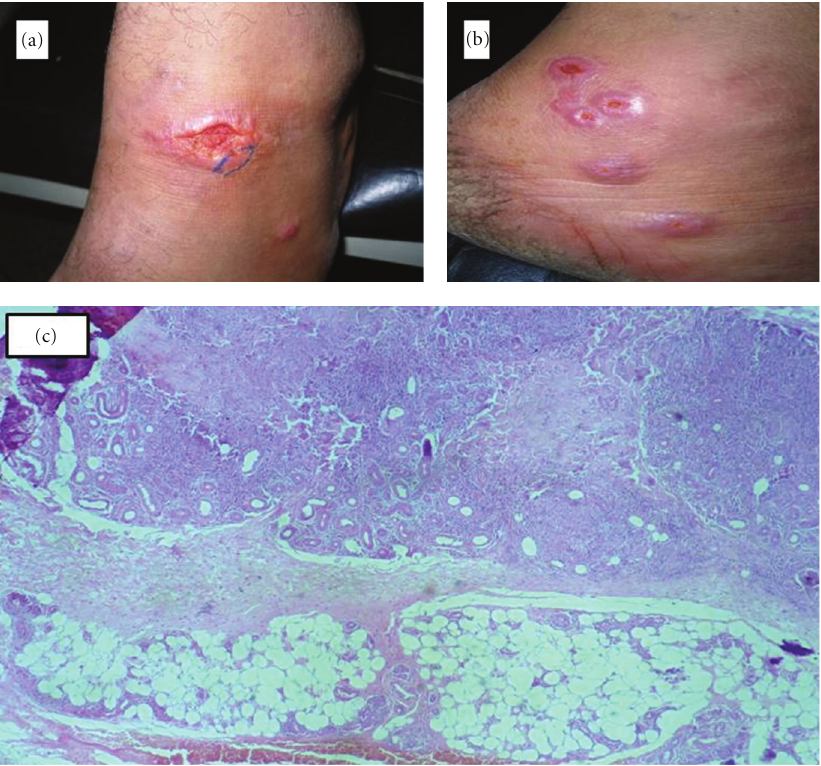
Figure 1: Ulcerative plaque on the dorsal foot, the blue elliptical line indicates the site of the biopsy (a), multiple ulcerative nodules behind the lateral malleolus (b), microscopic view of septal and lobular panniculitis H&E stain × 100